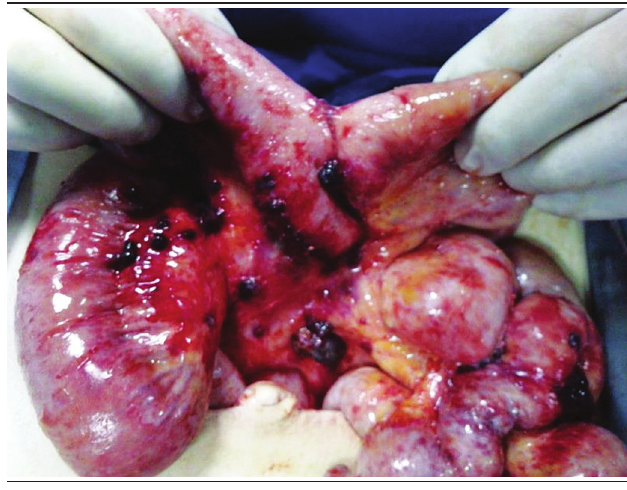
figurE 4 − Diffuse